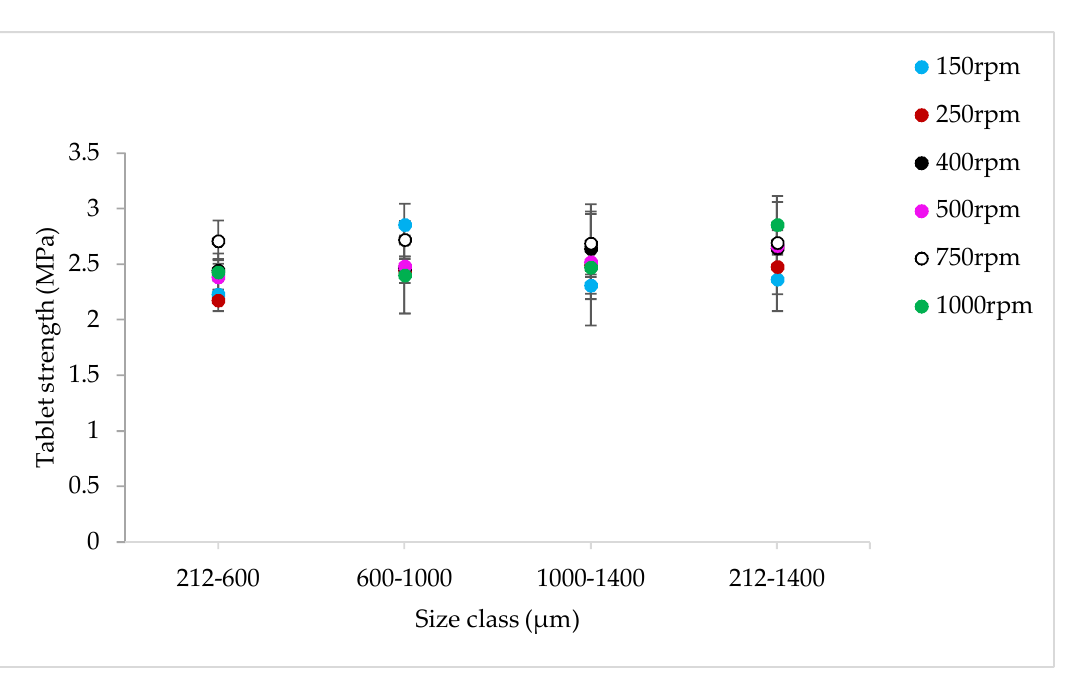
Figure 21. Tensile strength of tablets of MCC granules produced at varying screw speed at SFL—0.041 and PFN—3.37093 × 10 −5 (L/S 1).